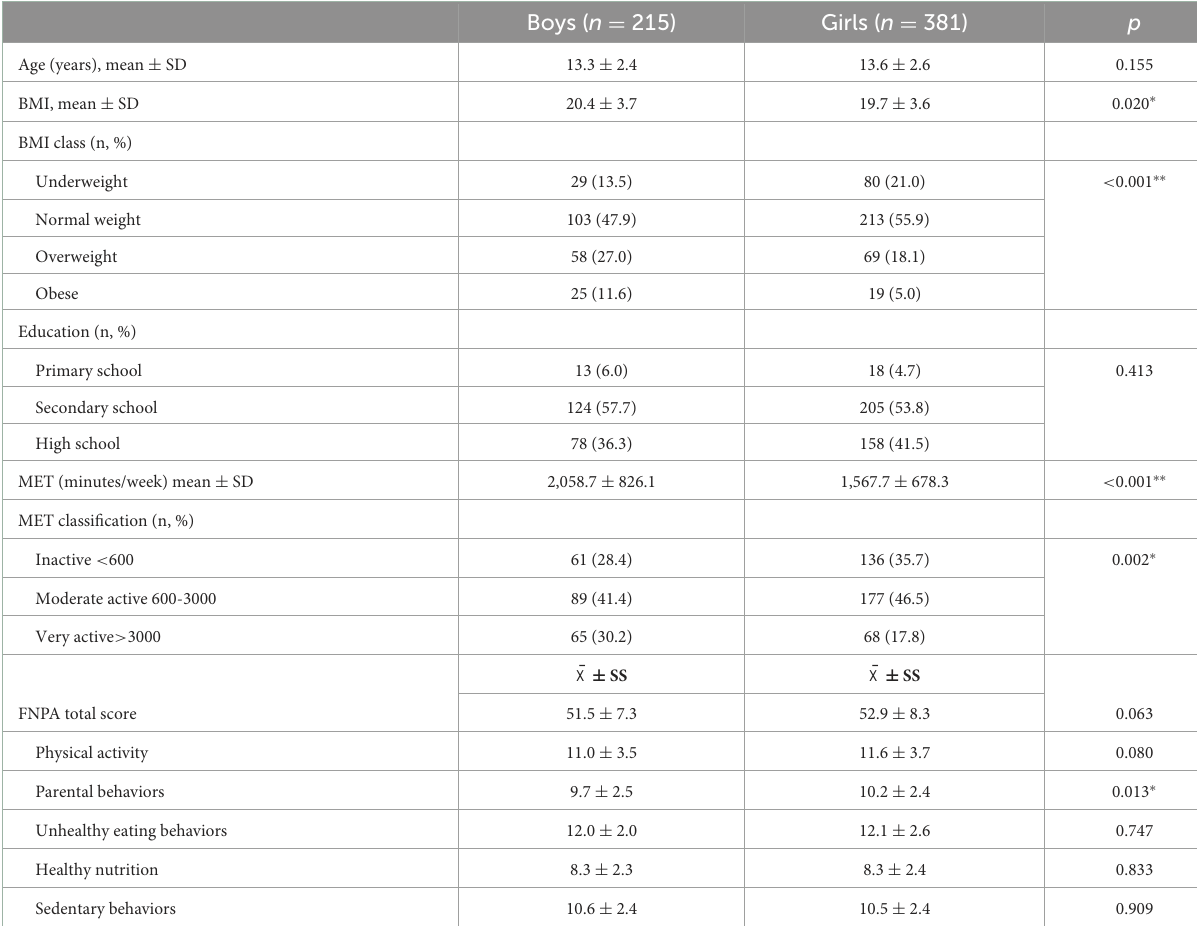
TABLE 2 Descriptive characteristics, BMI, physical activity levels, and FNPA scores according to